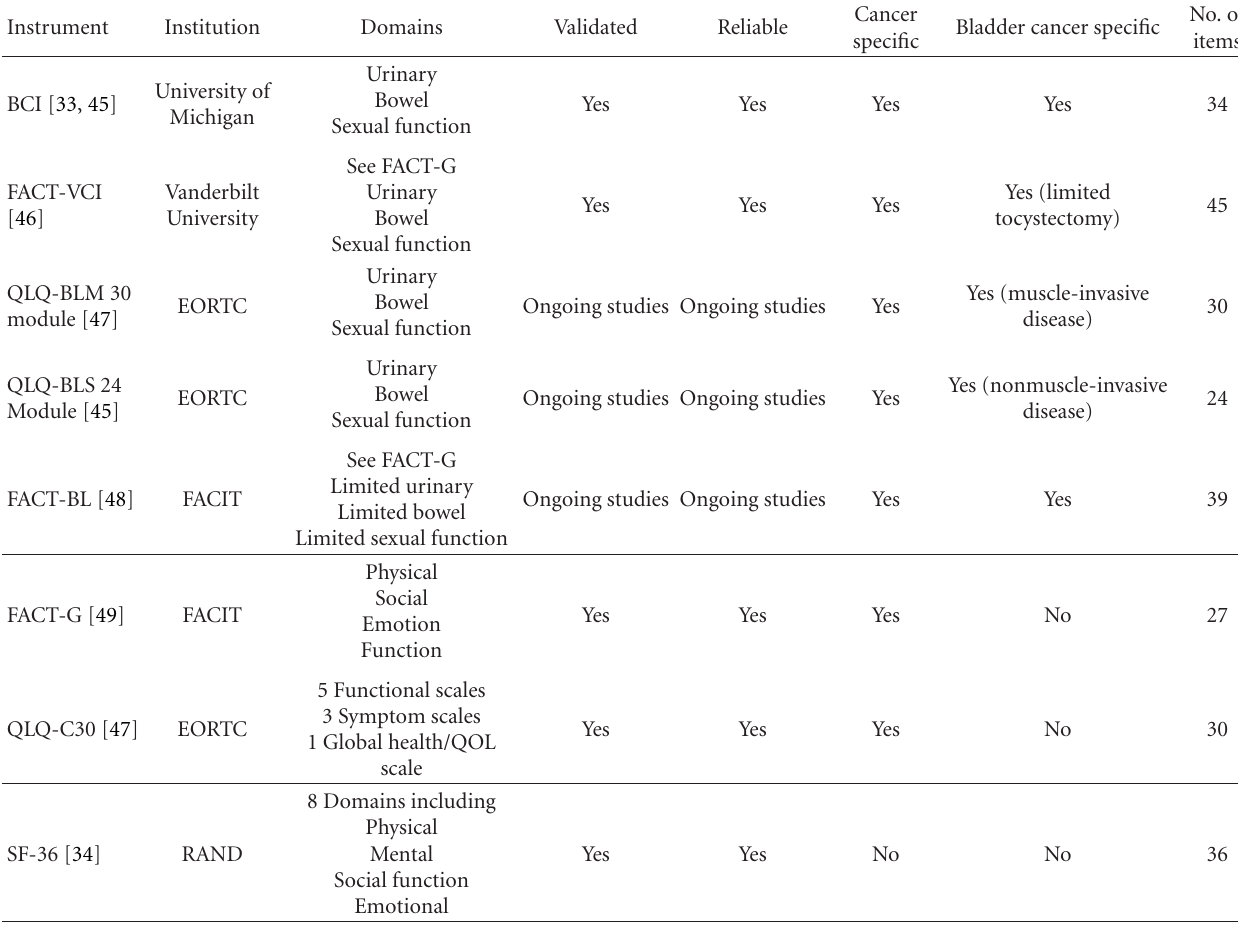
Table 1: Quality-of-life instruments. (With permission from Lee et al.